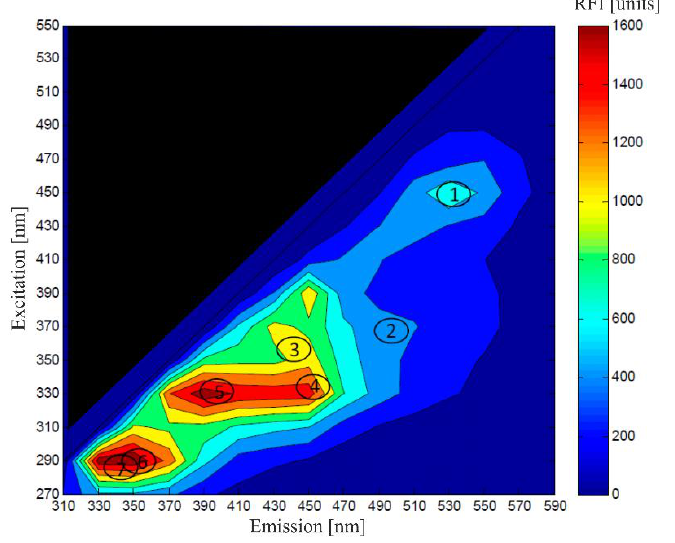
Figure 4. Fluorescence diagram of a fermentation broth of S. cerevisiae showing fluorescence signals of: (1) flavin, (2) riboflavin, (3) NADH, (4) NADPH, (5) pyridoxine, (6) tryptophan and (7) tyrosine. Adapted with permission from [47]. Faassen and Hitzmann, 2016.